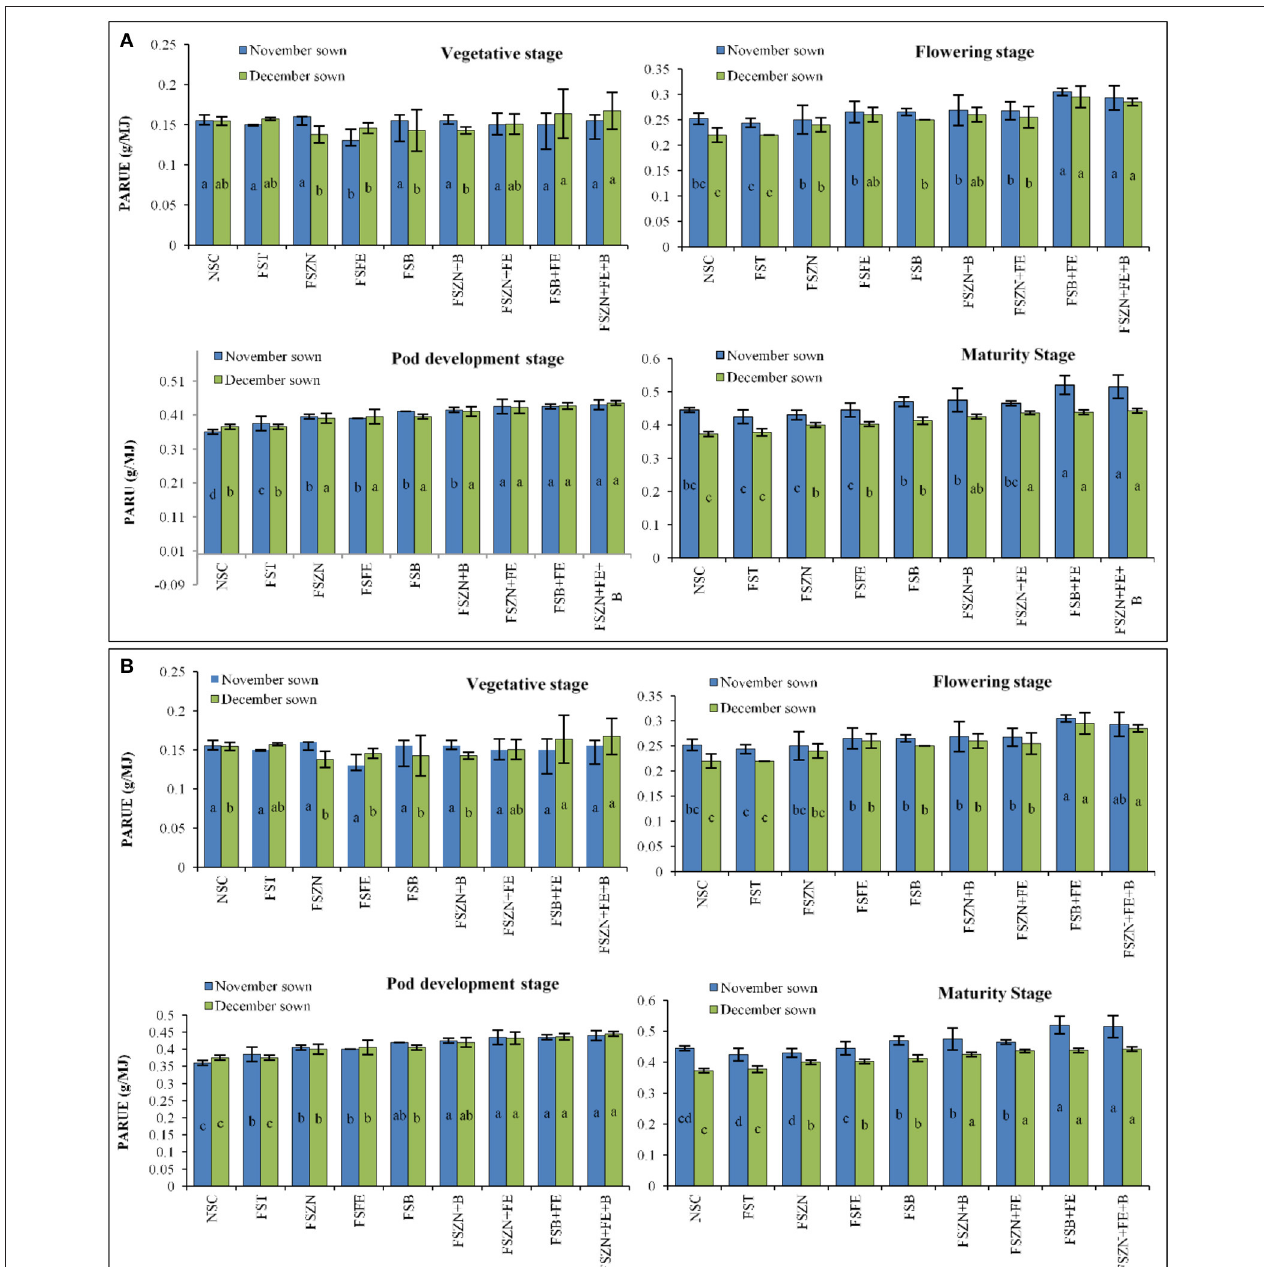
FIGURE 7 | (A) PARUE at different growth periods under different dates of sowing and foliar spray (data of 2018–2019 crop season) (error bars represent the standard error of the mean, and different letters indicate significant differences between means.); and (B) SDD index at different growth periods under different dates of sowing and foliar spray (data of 2019–2020 crop season) (error bars represent the standard error of the mean, and different letters indicate significant differences between means). Treatments details are available in Table 1 .